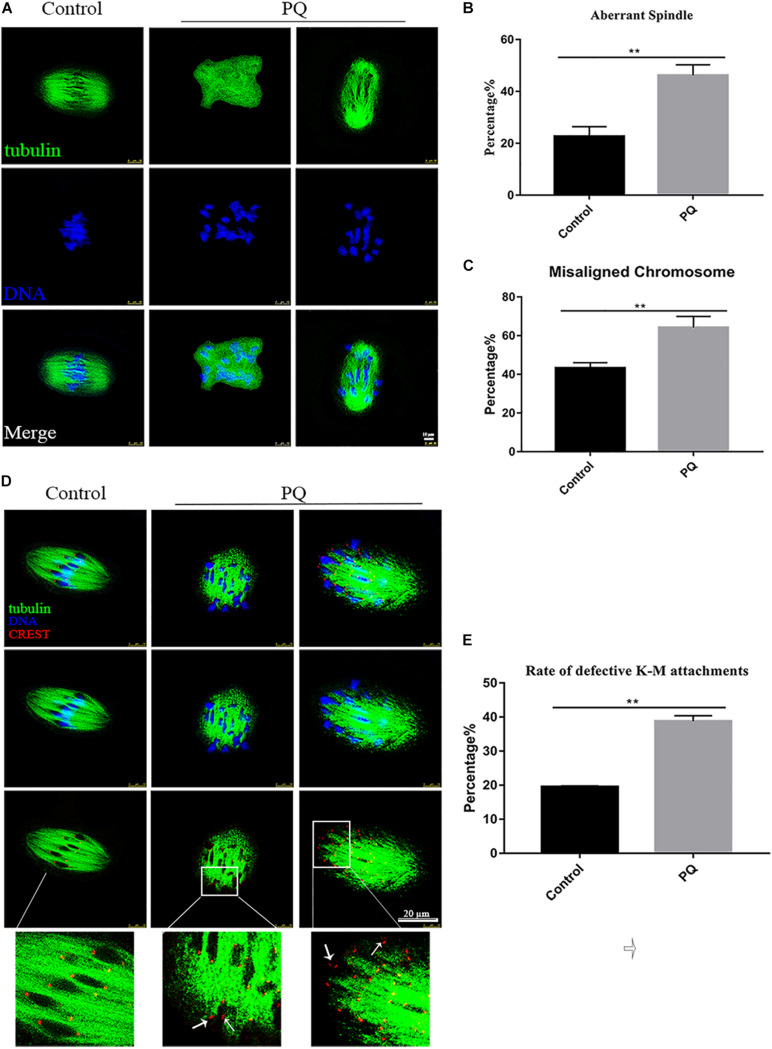
Paraquat (PQ) affects the meiotic spindle and chromosome dynamics in mouse oocytes. (A) Representative images of spindle morphology from the control and PQ-treated groups. Spindle (green) and DNA (blue). Scale bar = 10 μm. (B) The percentage of aberrant spindle in the control and PQ-treated groups. (C) The percentage of misaligned chromosome in the control and PQ-treated groups. (D) Representative images of kinetochore and microtubule (K-M) attachment from the control and PQ-treated groups. Images of kinetochores (red), microtubule (green), and DNA (blue) were observed by the confocal microscopy. The white arrow indicates the abnormal K-M attachment or no K-M attachment. Scale bar = 10 μm. (E) The rate of defective K-M attachments in the control and PQ-treated groups. Data are presented as mean ± SEM from at least three independent experiments. ∗∗P < 0.01.